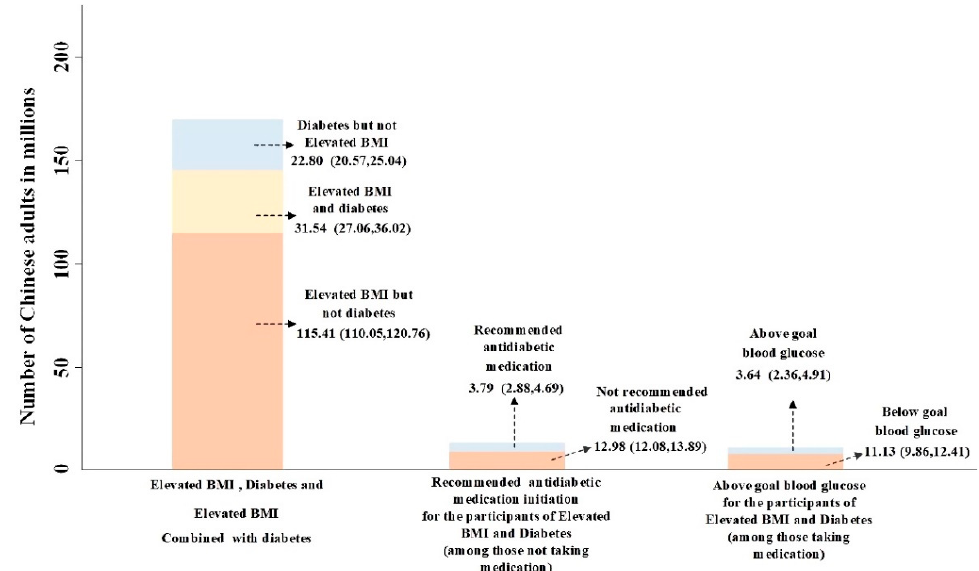
Figure 2. Number of Chinese adults who have elevated BMI, diabetes, or both, who are recom- mended initiating antidiabetic medication among those not taking antidiabetic medication and those with diabetes combined with elevated BMI or with above goal blood glucose among those taking antidiabetic medication. Data used for estimating were from the CHARLS 2011–2012 baseline survey.